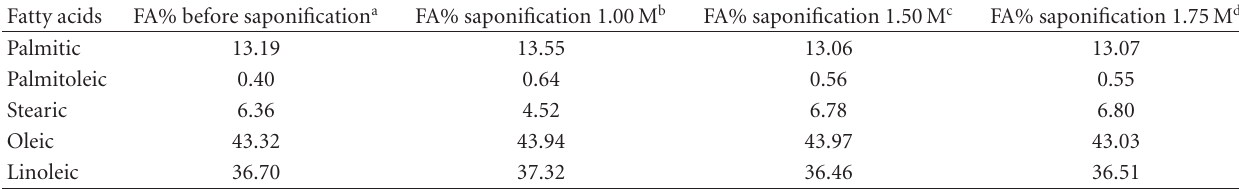
Table 5: D-optimal design arrangement for the concentration e ff ect of ethanolic alkaline solution KOH, temperature ( ◦ C) and time (h) to the FAs composition before and after the